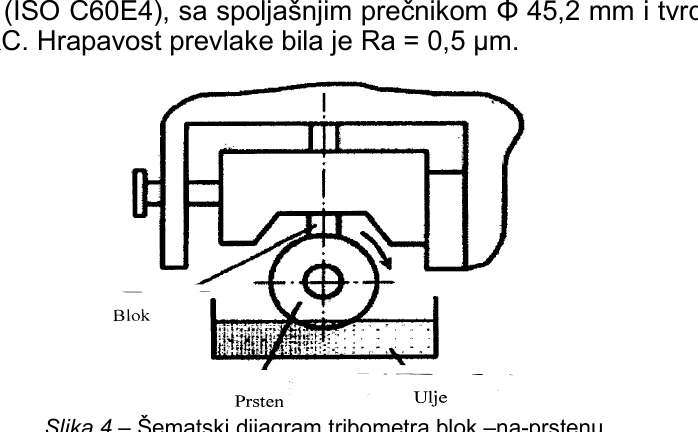
Figure 4 – Schematic diagram of a pin – on – ring